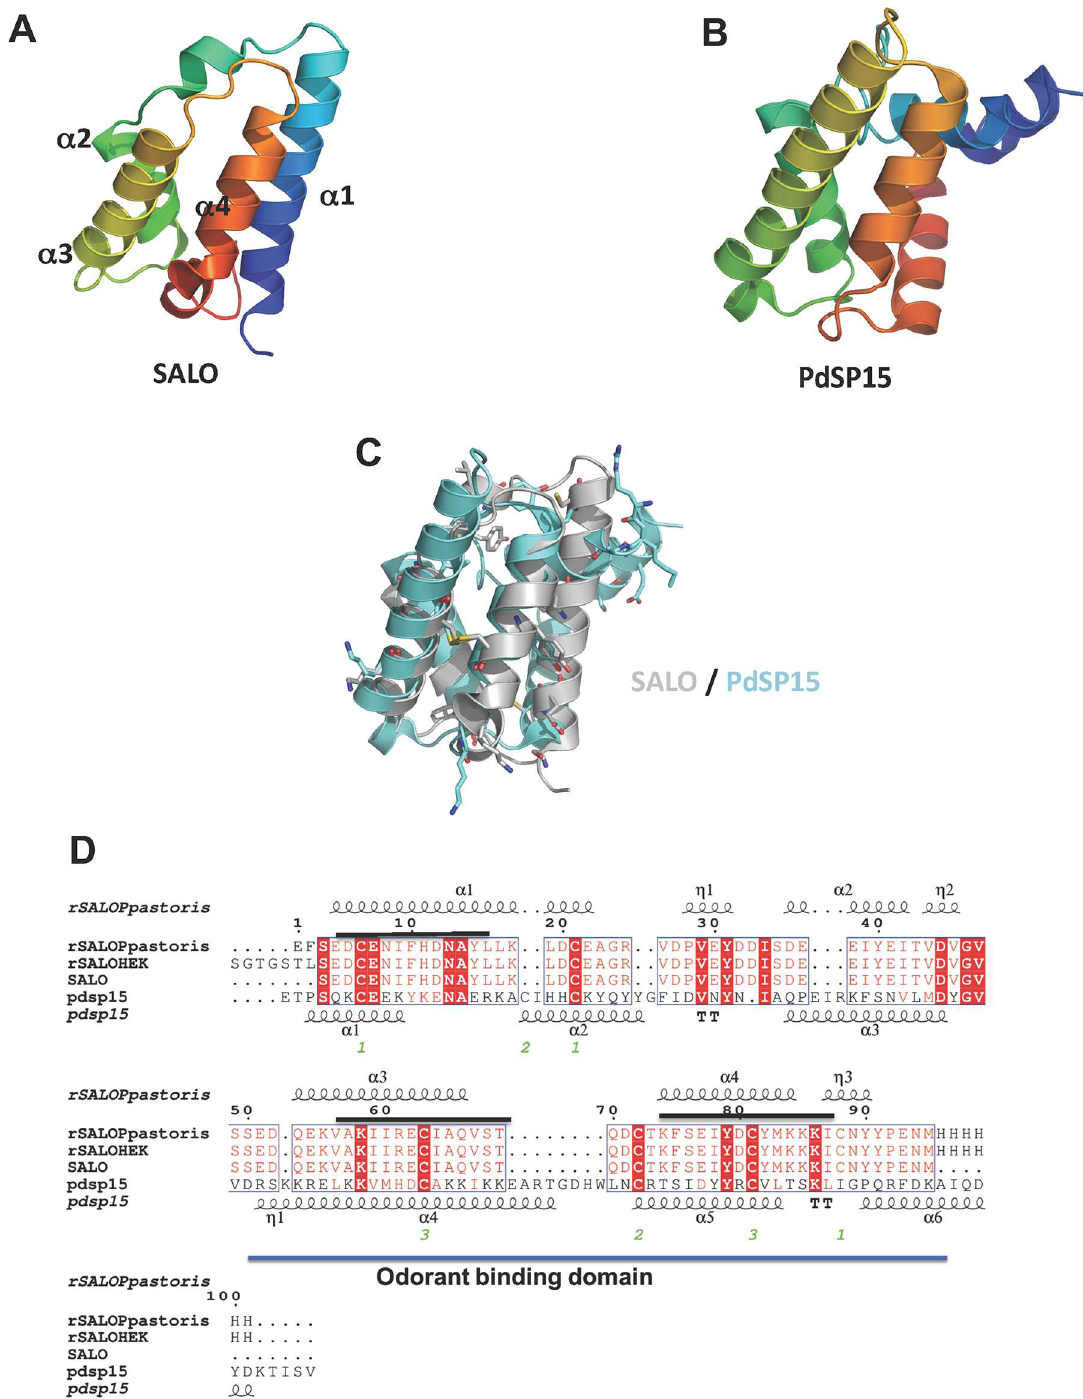
Fig 5. Comparison of SALO to PdSP15. (A) Ribbon diagramof a SALO monomer. (B) Ribbondiagram of pdsp15(C) C- terminus of SALO (grey) superposes well with PdSP15 (aqua marine). (D) The amino acid sequencealignment comparing SALO to PdSP15 generatedwith ESPript 3.0[36] reveals a conservedC-terminal odorant-binding domain.The locationof the three predictedT-cell epitopes are shown as black lines. Secondary-structure elementsare as follows: α -helices( α ), 3 10 - helices( η ), β -strands ( β ) and β -turns (TT). Identicalresiduesare shown on a red background;conservedresidues are shown in red; and conservedregions are shown in blue boxes.